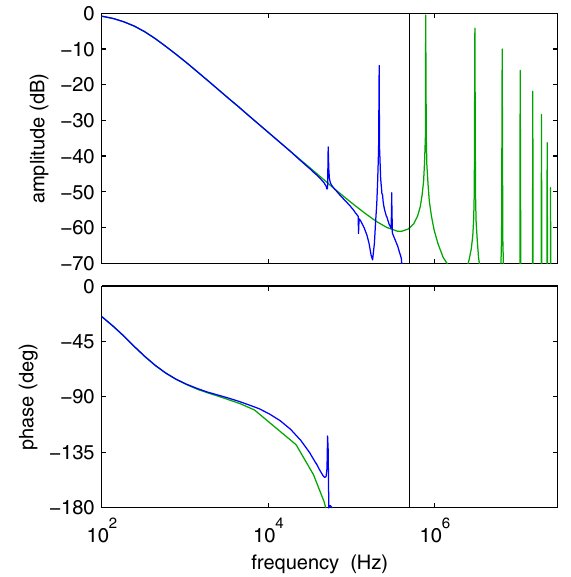
FIG. 6. (Color) Bode plot of the discrete single cavity open loop transfer function (blue) for 1 MHz sampling rate, unity gain G (cid:3) (cid:3) 5 (cid:1) s . The 8 (cid:2) -mode maximum trans- 1 , and loop delay (cid:4) loop 9 mission value is aliased from 785 to 215 kHz and reduced to a level of (cid:4) 14 : 6 dB . For comparison, the bode plot of the con- tinuous system is also shown